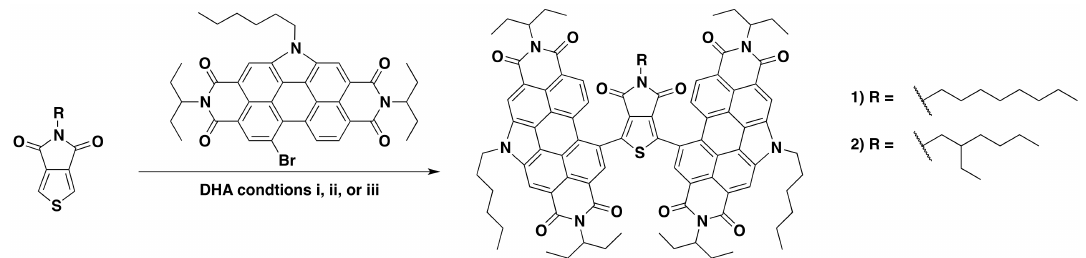
Figure 2. Reaction scheme for the synthesis of compounds 1 and 2 . (i) Toluene, 120 ◦ C, Cs 2 CO 3 , pivalic acid, Pd(Herrmann-Beller), and P( o -anisyl) 3 ; (ii) DMA, 80 ◦ C, Cs 2 CO 3 , pivalic acid, and Silia Cat ® DPP-Pd; and iii) toluene, 120 ◦ C, Cs 2 CO 3 , pivalic acid, and Silia Cat ®